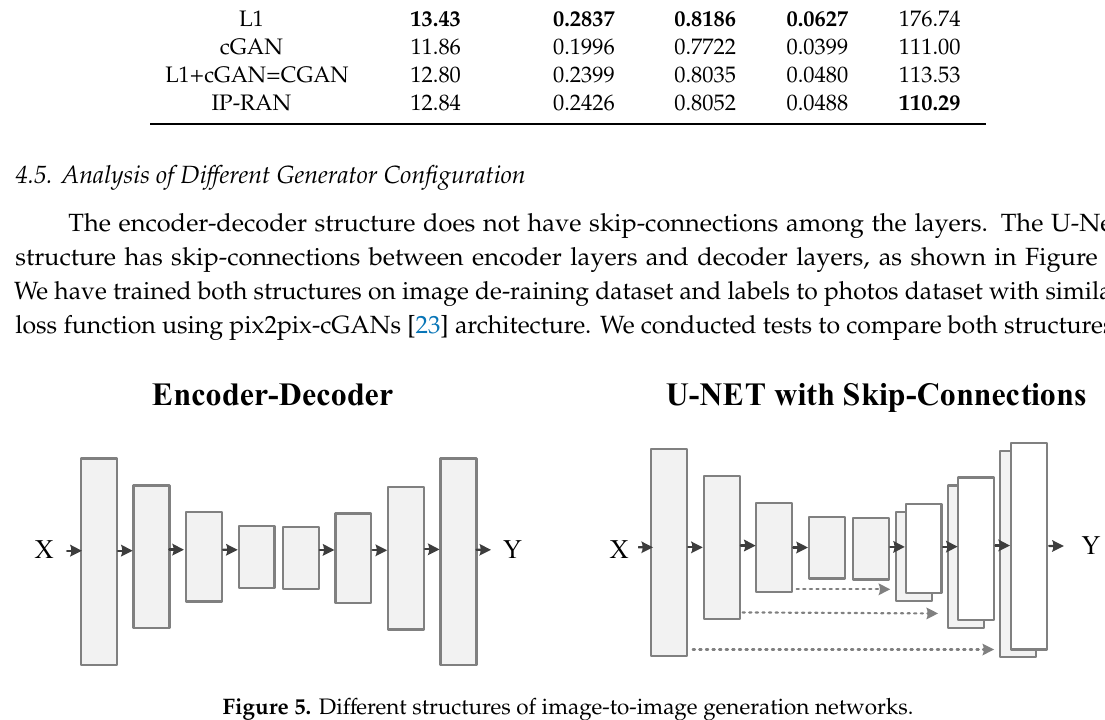
Figure 5. Di ff erent structures of image-to-image generation Figure 5. Different structures of image-to-image generation networks.